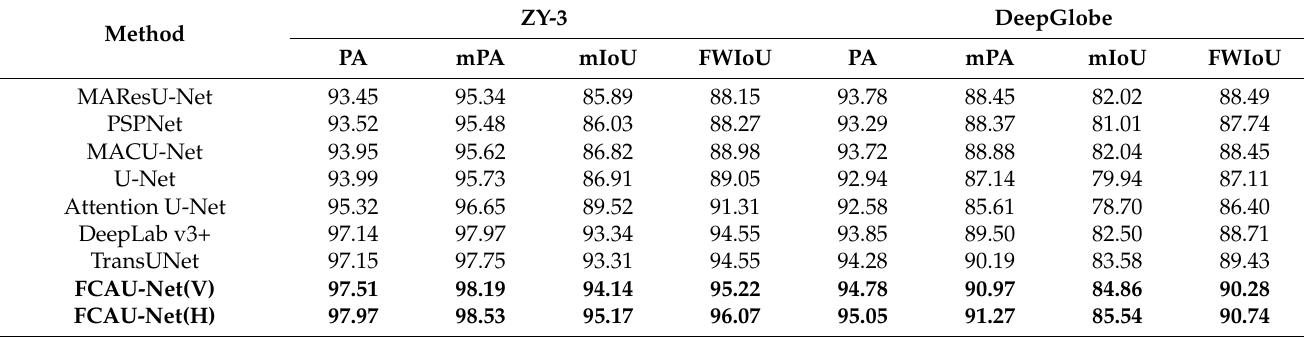
Table 2. Experimental results obtained on the ZY-3 and DeepGlobe datasets